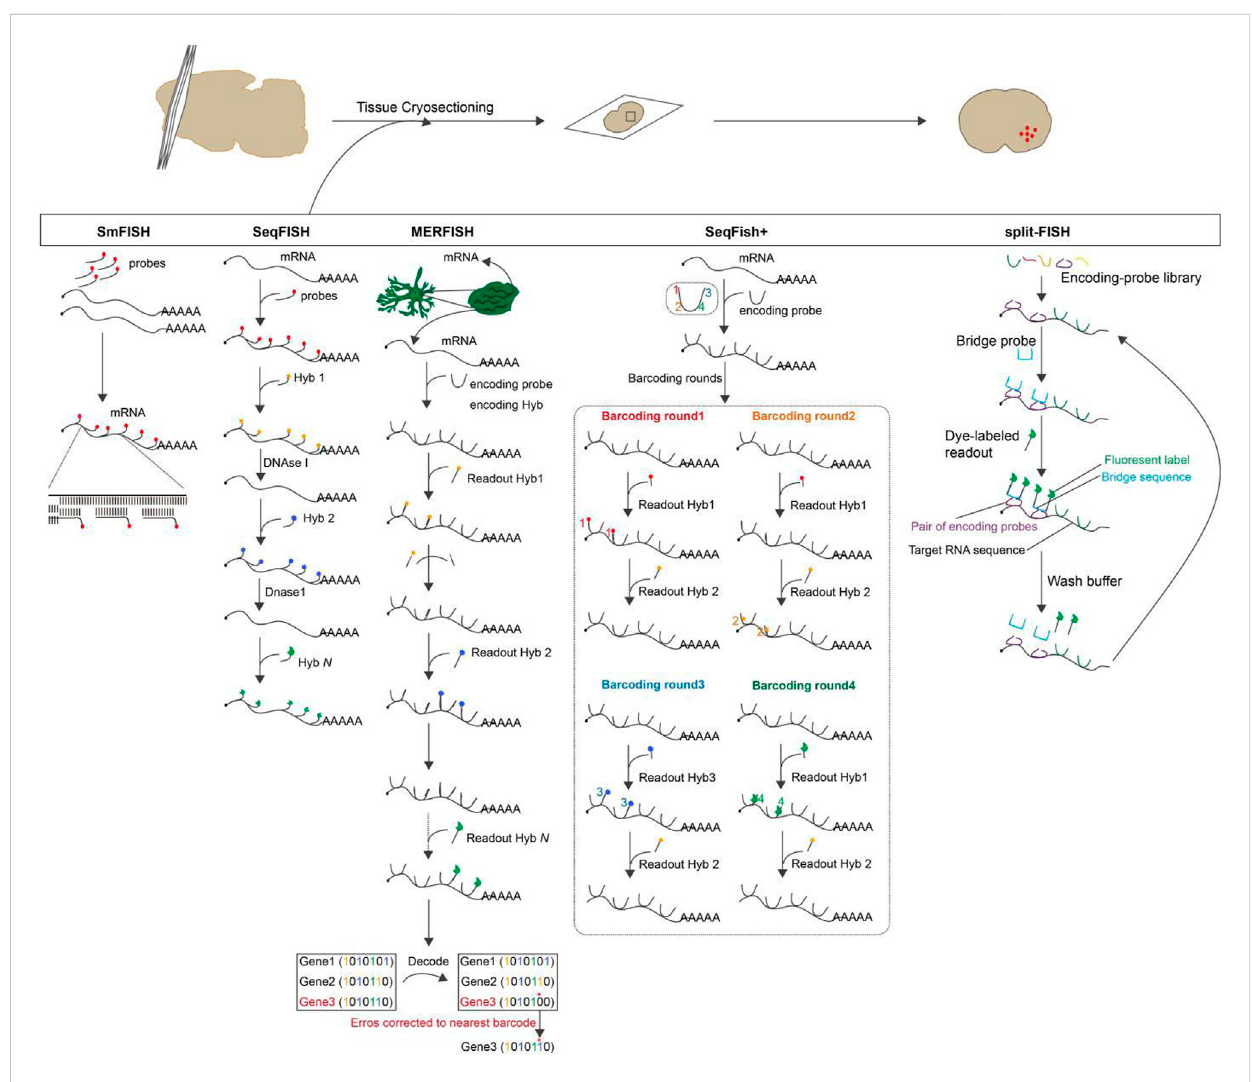
FIGURE 2 The overview and principle of spatial transcriptome technologies based on in situ hybridization.